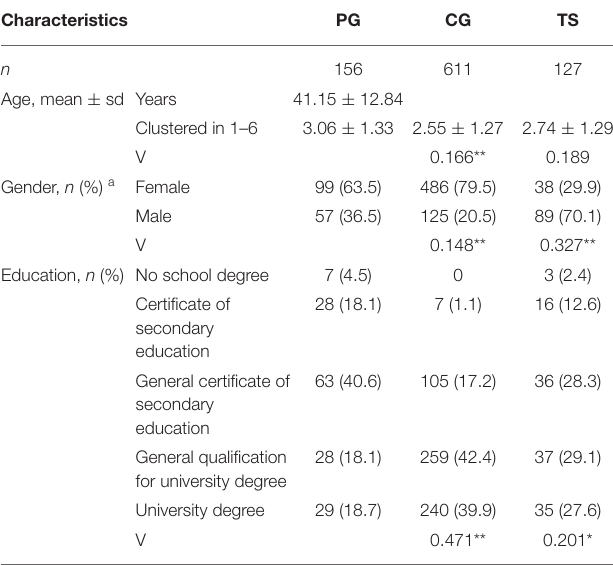
TABLE 1 | Demographic characteristics of the mixed psychiatric group (PG) compared to the control group (CG) and patients with Tourette syndrome (TS).